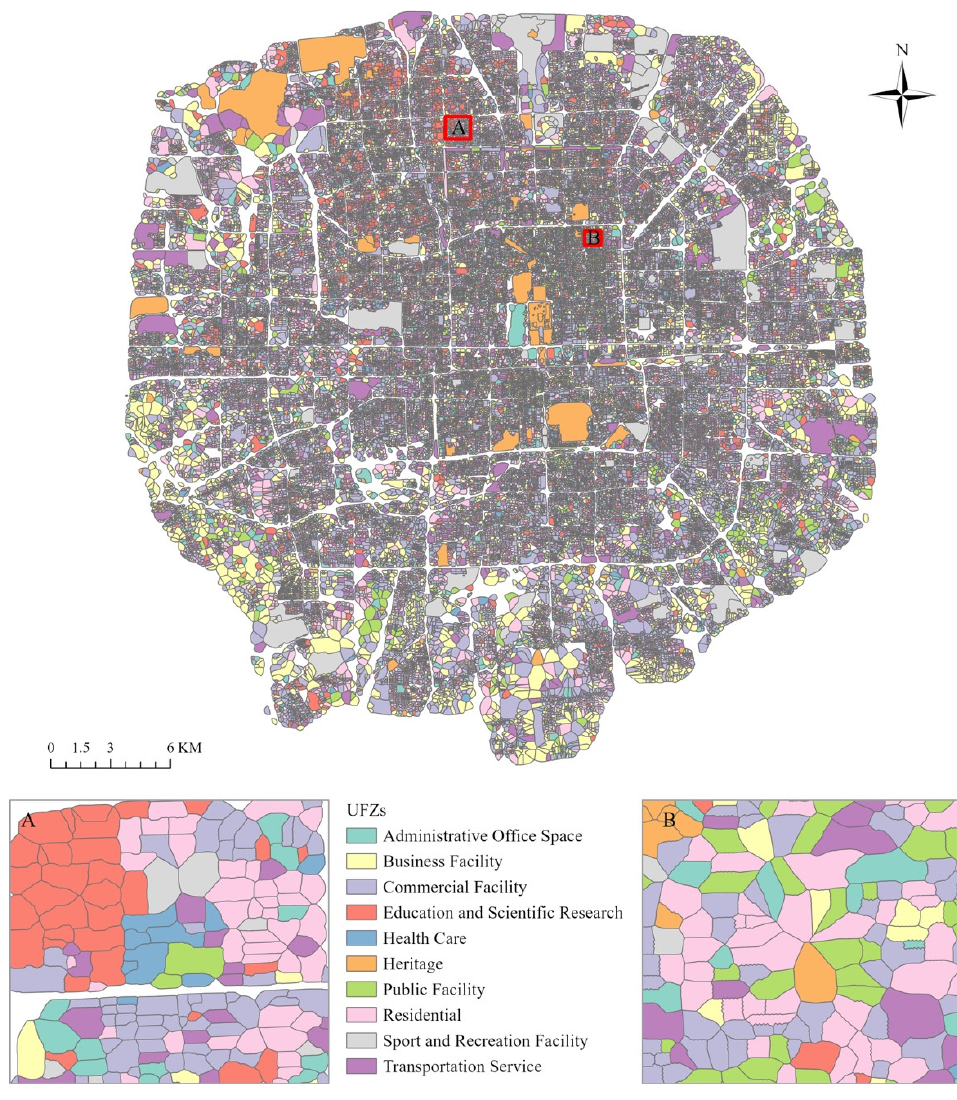
Figure 11. UFZ classification results (proposed